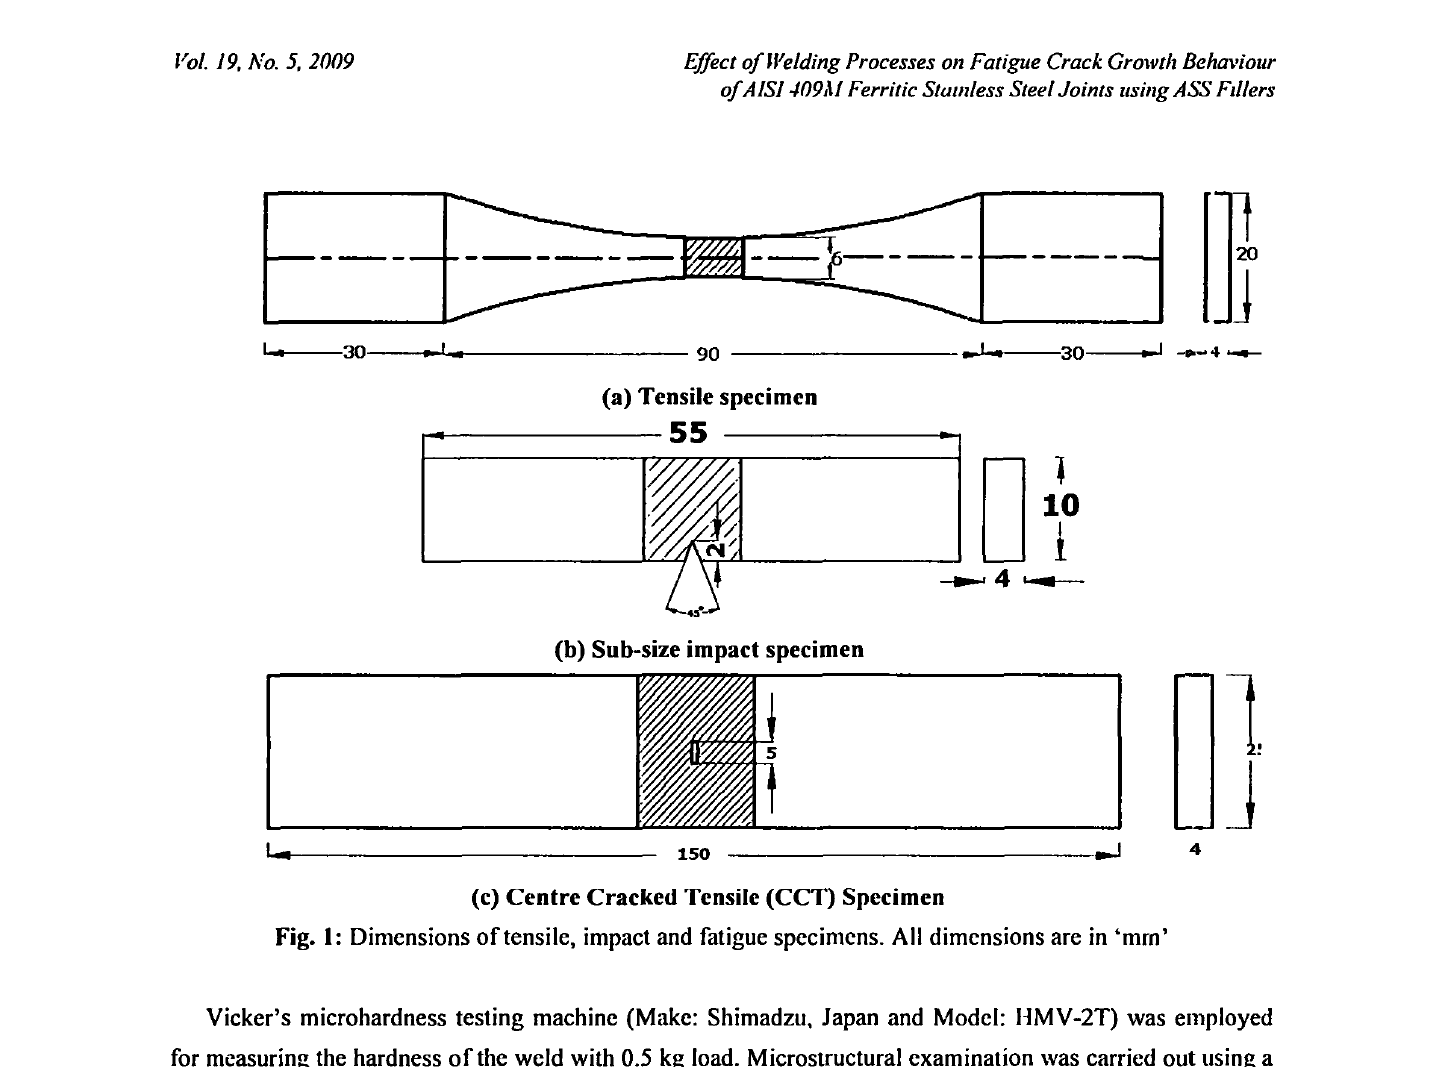
Fig. 1: Dimensions of tensile, impact and fatigue specimens. All dimensions are in